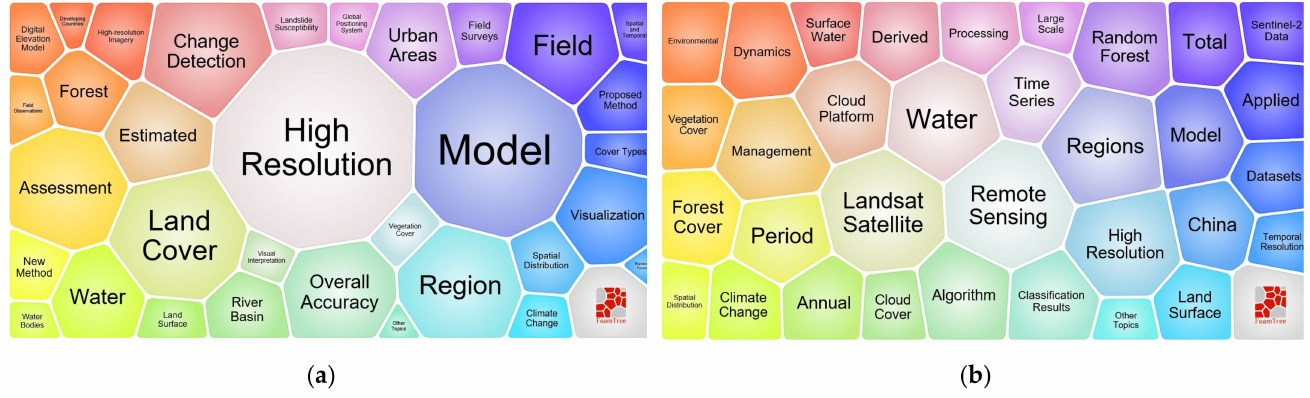
Figure 4. Keywords related to ( a ) GE and ( b )